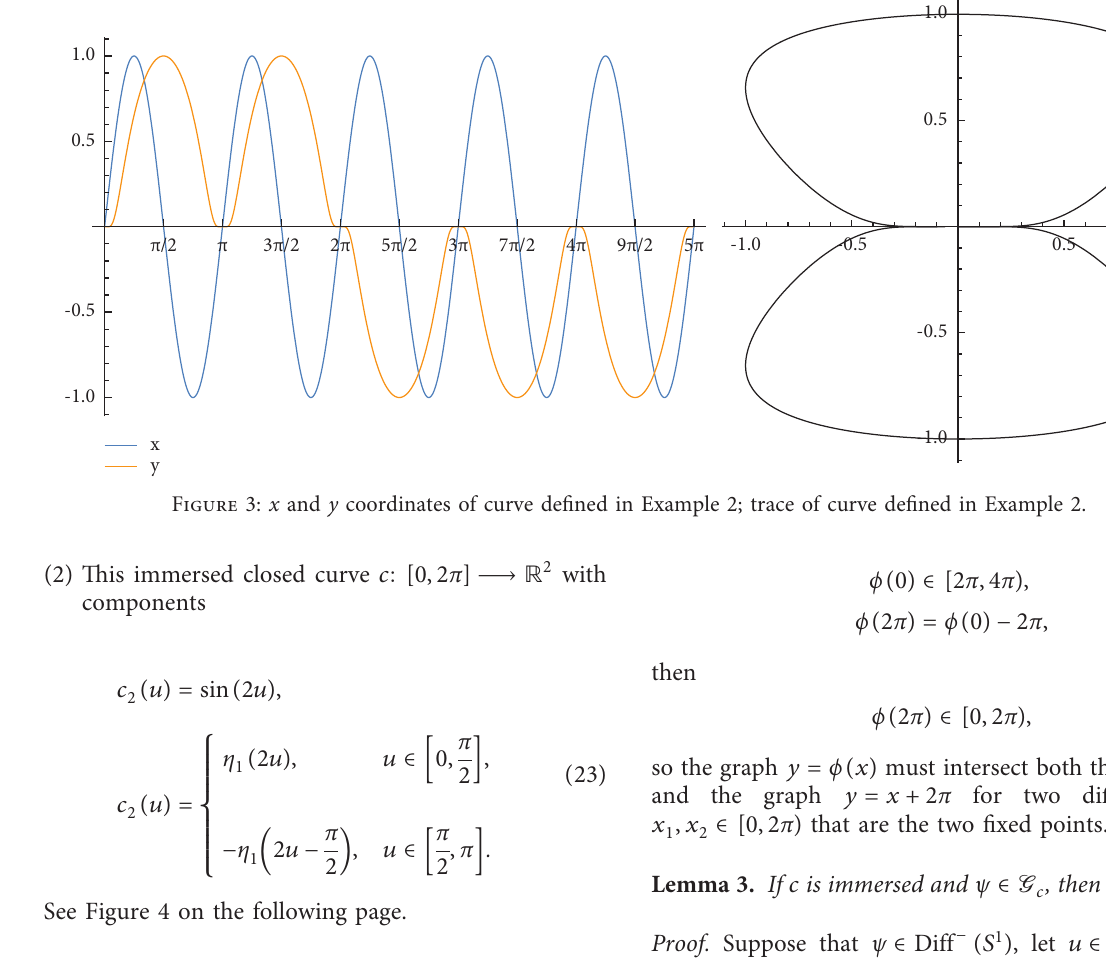
as defined in 1